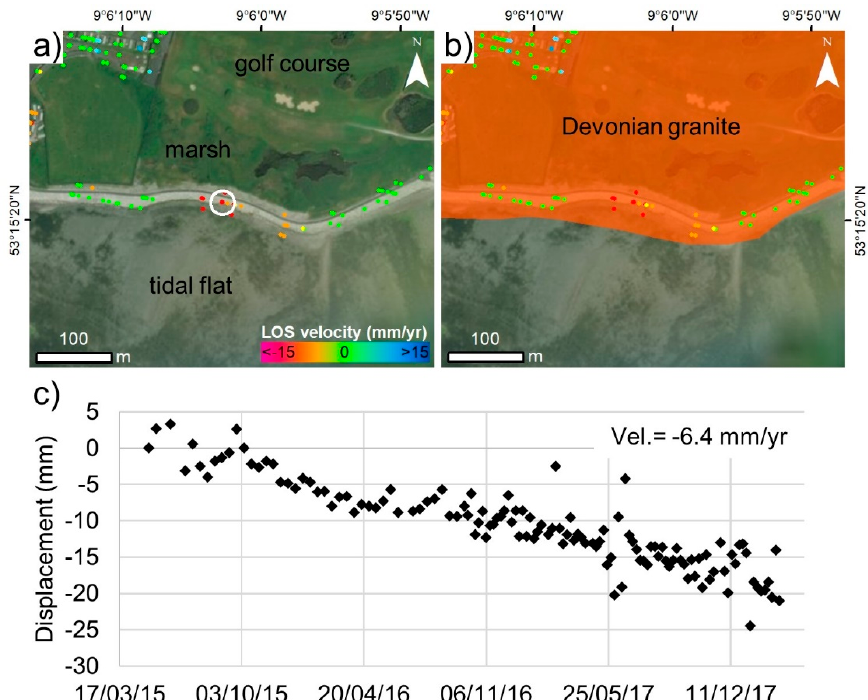
Figure 11. Subsidence of a coastal defense wall in Galway city (denoted locality ‘c’ in Figure 7): ( a ) coastal road embankment showing signs of instability. ( b ) Bedrock geology map; the colors correspond to the legend in Figure 4a. ( c ) Displacement time series of the selected point (white circle).